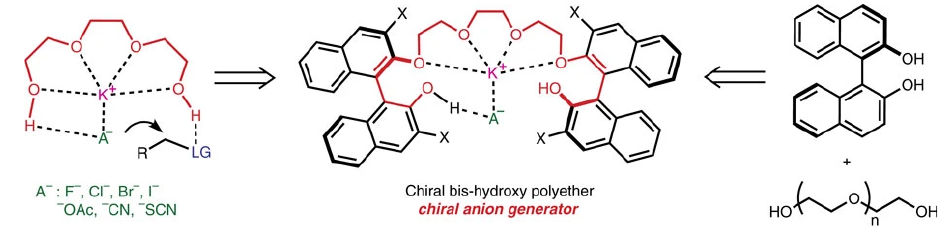
Figure 2. Chiral bis-hydroxy polyether as a chiral anion generator [25]. Reprinted with permission